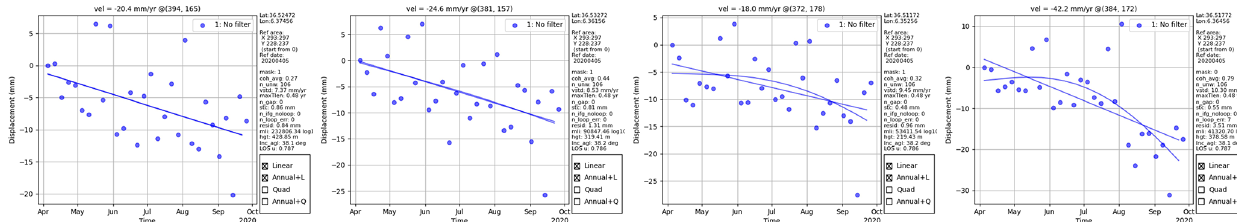
Figure 18. Displacement time series (orbit 66, Grarem case), corresponding to the points in image (Fig. 17b); the displacement is relative to a reference point, and the plots present a great dispersion of data points, which is related to many noise resources (weather, manmade, etc.) and short period of analysis (QGIS, ESRI